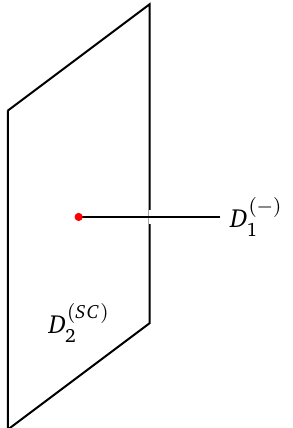
b D p SC q to 1 1 shown in the 2